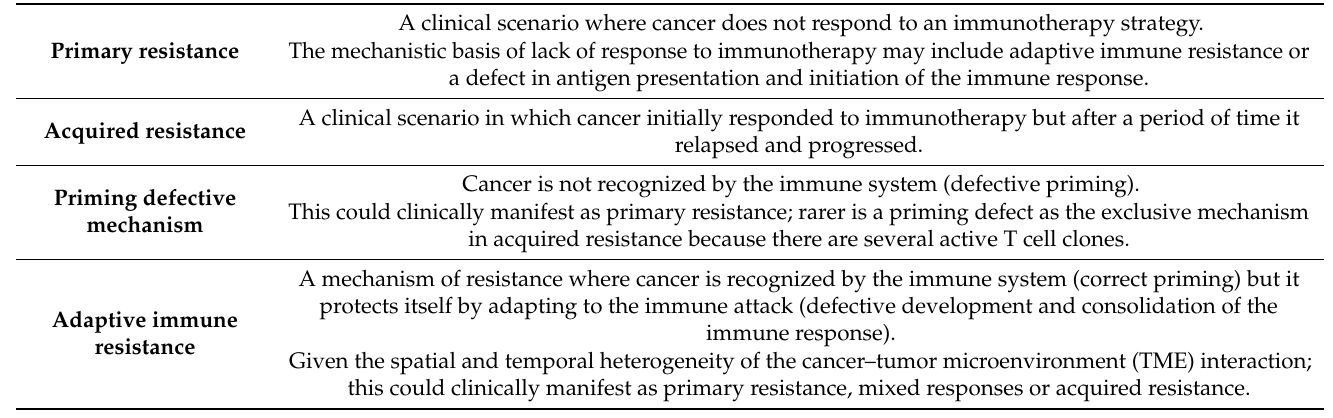
Table 3. Definition of different types of resistance to immunotherapy.